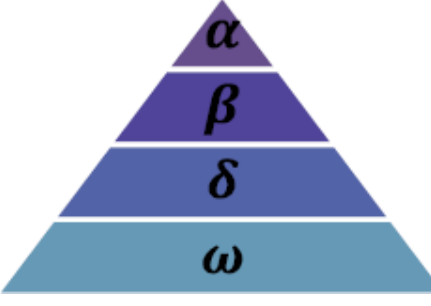
Figure 2. Hierarchy of the gray wolf.